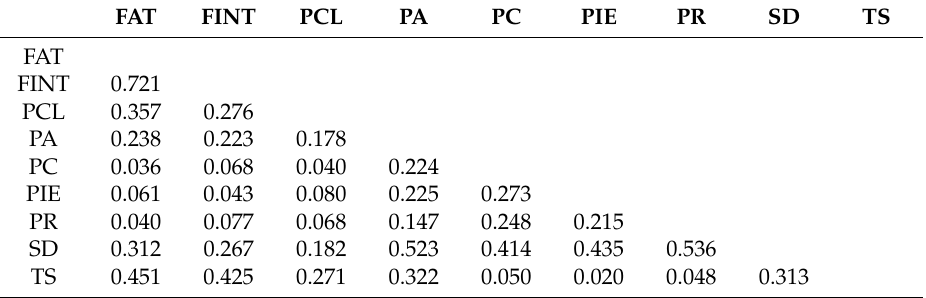
Table 4. Test of discriminant validity using the heterotrait-monotrait ratio of correlations (HTMT)